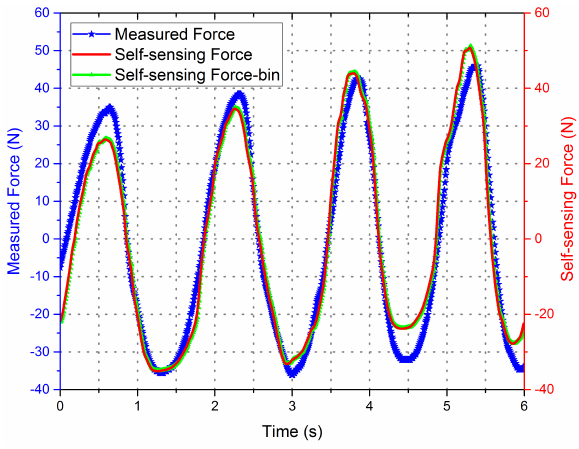
Figure 11. Comparison of the self-sensing and measured force curves with drive current = 0.01